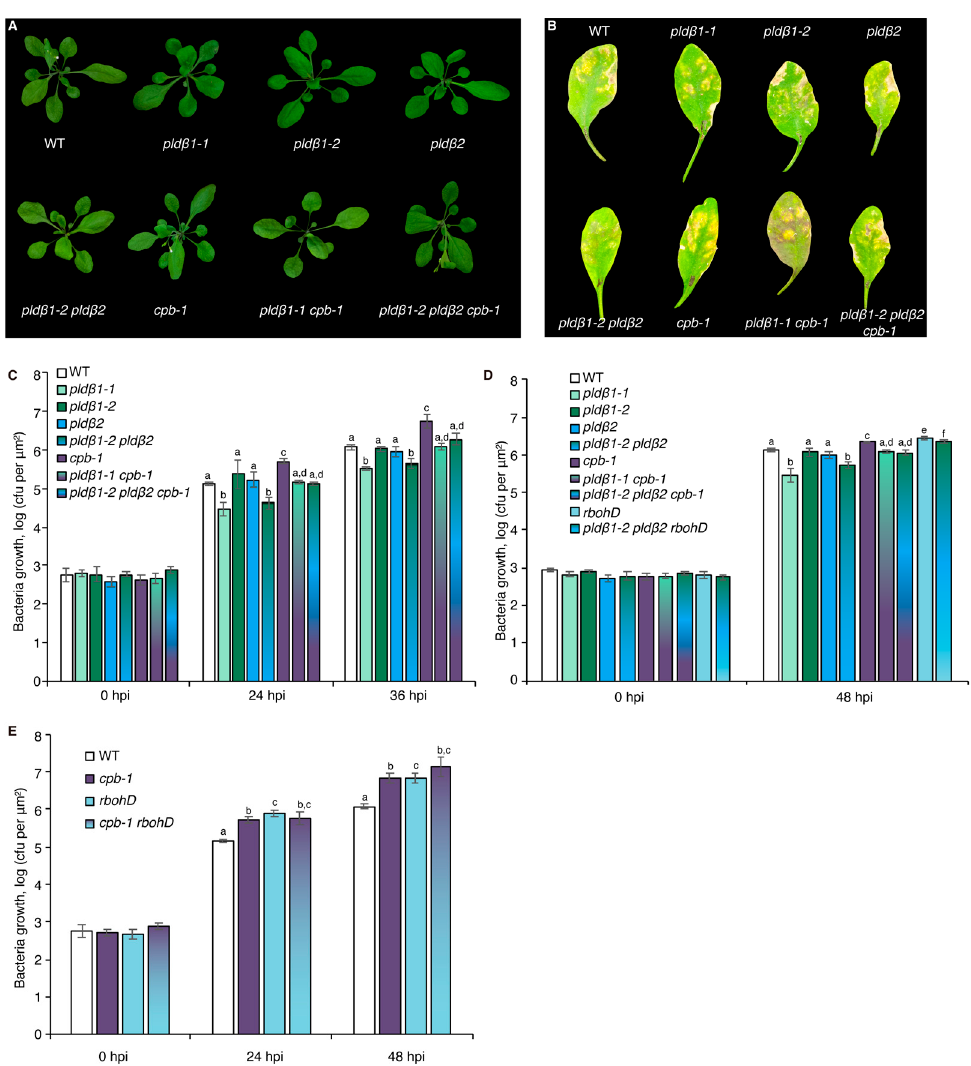
Figure 2. PLD β acts upstream of RBOHD to defend against bacterial pathogen proliferation. ( A ) Representative images of A. thaliana plants including WT (Col-0) and pld β 1-1 , pld β 1-2 , pld β 2 , and cpb-1 homozygous single mutants, pld β 1-1 cpb-1 and pld β 1-2 pld β 2 double mutants, as well as pld β 1-2 pld β 2 cpb-1 triple mutant. Plants were cultivated for 4 weeks under long-day conditions and pho- tographed. No obvious phenotypic differences were detected in pld β single, double, or triple mutants compared to WT. ( B ) Qualitative images of infected leaves from WT, pld β 1-1 , pld β 1-2 , pld β 2 , cpb-1 , pld β 1-1 cpb-1, pld β 1-2 pld β 2 as well as pld β 1-2 pld β 2 cpb-1 triple mutant at 36 h post infection (hpi). ( C ) Quantification of bacterial growth in Arabidopsis leaves infiltrated with Pseudomonas syrin- gae pv. tomato ( Pst ) DC3000. Leaves were sampled at 0, 24, and 36 hpi to measure the growth of bacterial pathogens. At 0 hpi, there were no significant differences for bacterial growth detected among the genotypes tested. At 36 hpi, pld β 1-1 (light green) and pld β 1-2 pld β 2 (gradient from dark green to blue) supported significantly less bacterial growth compared to WT (white), whereas bac- terial growth in pld β 1-2 (dark green) and pld β 2 (blue) was indistinguishable from WT; cpb-1 (purple) was susceptible to bacterial pathogen infection compared to WT, supporting more growth of viru- lent Pst DC3000, as reported previously [20]. Moreover, when cpb-1 was combined with pld β 1-1 and pld β 1-2 pld β 2 mutants, the double (gradient from light green to purple) and triple (blend of dark green, blue and purple) mutants were more susceptible to bacterial growth than pld β 1-1 and pld β 1-2 pld β 2 alone. This epistatic genetic relationship indicated that CP functions downstream from PLD β . At least three independent biological repeats with similar findings were conducted. ( D ) An- other independent bacterial infection assay was performed with the mutants in ( C ), as well as rbohD (light blue) and pld β 1-2 pld β 2 rbohD (gradient from light blue to green). Similar conclusions about pld β mutants and cpb-1 could be drawn from this repeat. Here, rbohD was susceptible to virulent pathogen growth at 48 hpi, as expected. Moreover, pld β 1-2 pld β 2 rbohD was susceptible to bacterial